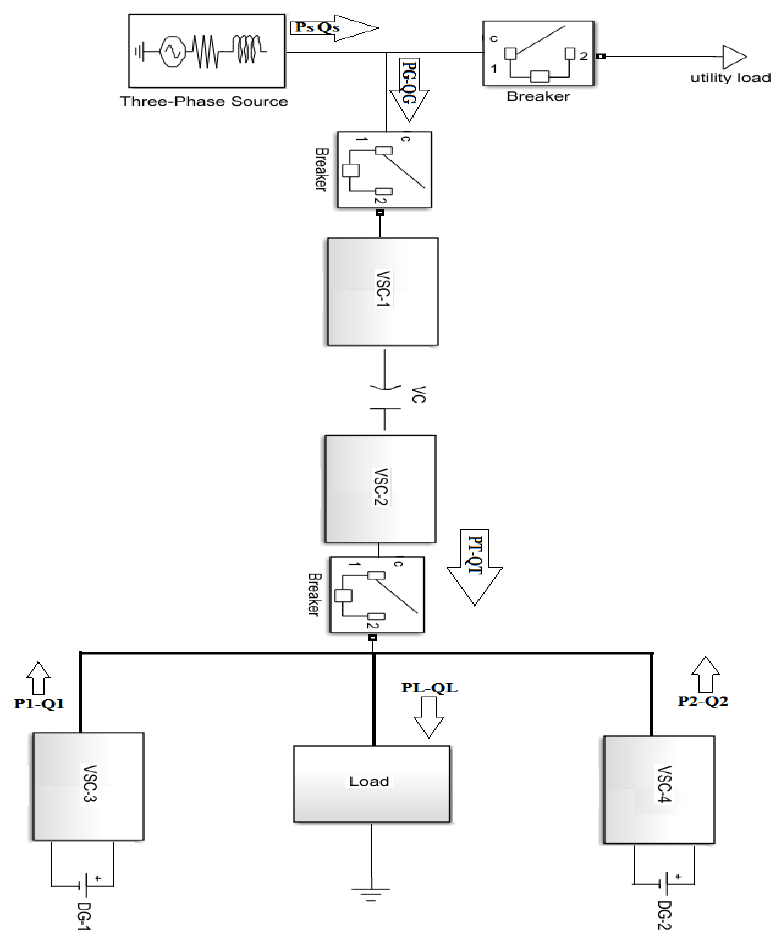
Figure 1. A schematic of microgrids, converters and micro sources [28].